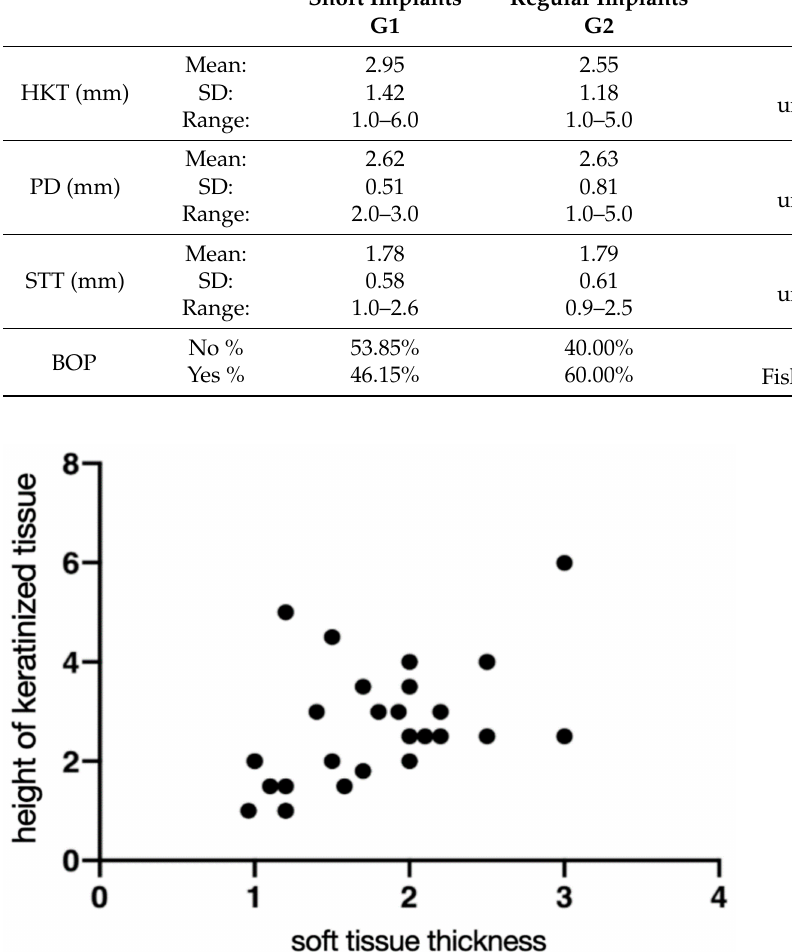
Figure 6. Correlation between the height of keratinized tissue (HKT) (seven years) and soft tissue thickness (STT) measured with Pirop ® ultrasonography device, presented value in (mm). Each dot represents an individual